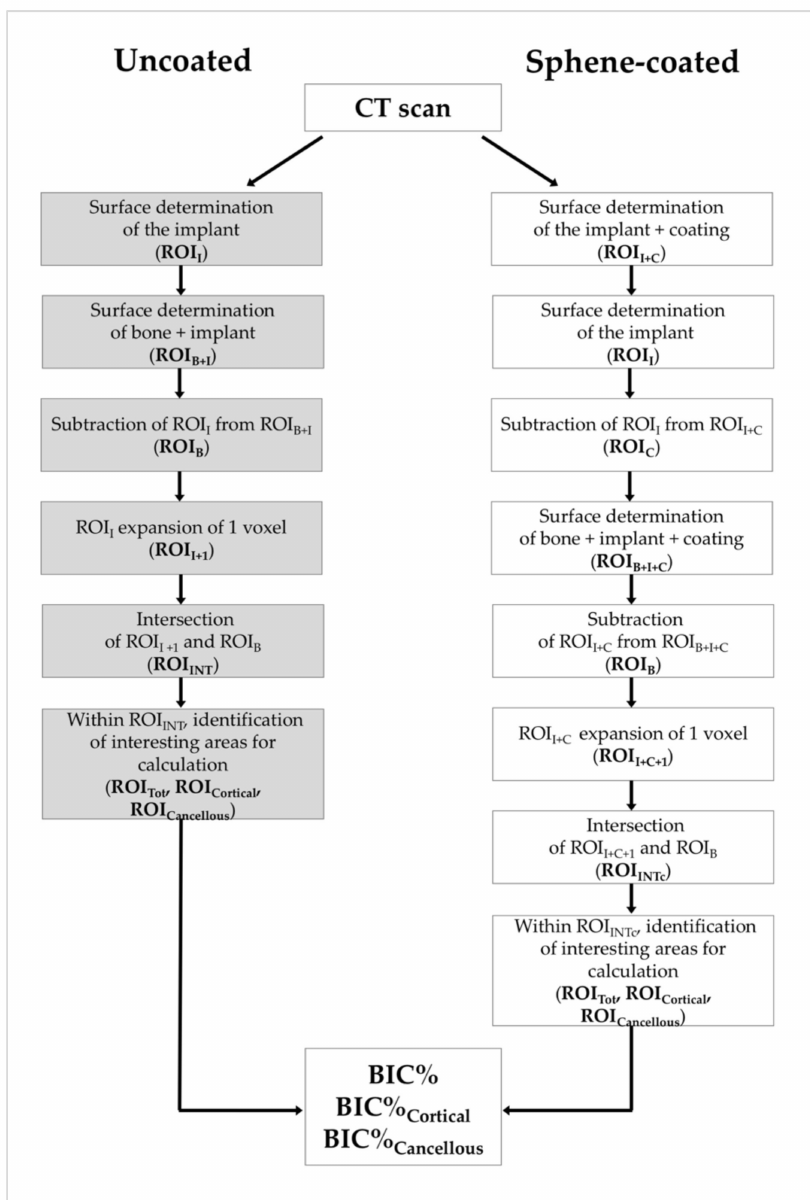
Figure 4. Workflow of the micro-computed tomography (micro-CT) analysis. BIC%: Bone to Implant Contact. BIC% Cortical and BIC% Cancellous : BIC% obtained in cortical and cancellous bone zones, respectively. ROI: Region of Interest. ROI I —ROI implant; ROI B —ROI bone; ROI B + I —ROI bone + implant; ROI I + 1 —ROI implant + 1 voxel; ROI INT —ROI intersection; ROI TOT —ROI total; ROI Cortical —ROI cortical; ROI Cancellous —ROI cancellous; ROI I + C —ROI implant + coating; ROI C —ROI coating; ROI I + C —ROI implant + coating; ROI B + I + C —ROI bone + implant + coating; ROI I + C + 1 —ROI implant + coating + 1 voxel; ROI INTc —ROI intersection